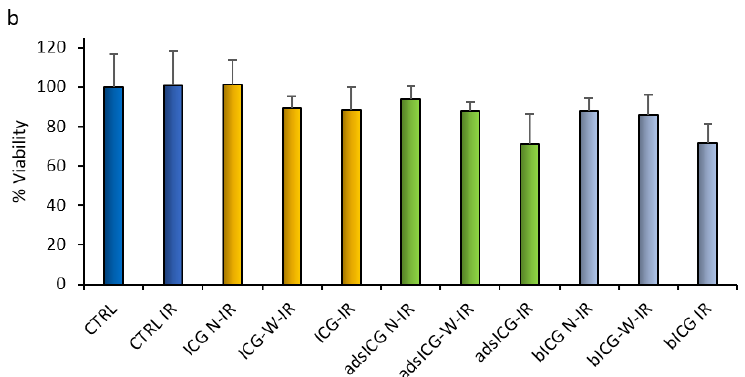
Figure 10. Caco-2 cell viability percentage (with respect to the controls) after 24 h exposure to the samples. Samples were not irradiated (N-IR) or irradiated after sample washing (W-IR) or without washing (IR) for 15 min at 0.1 W/cm 2 ( a ) or 5 min at 0.3 W/cm 2 ( b ). CTRL: untreated cells (controls). IR: irradiated samples. N-IR: samples not irradiated. W-IR: cells maintained in contact with the samples for 24 h and washed just before irradiation. ICG: dye solution. adsICG: ICG loaded NPs by adsorption. encICG: ICG-loaded NPs by encapsulation. bICG: NPs without resveratrol, ICG-loaded by adsorption. Mean ± s.d., n = 8 .